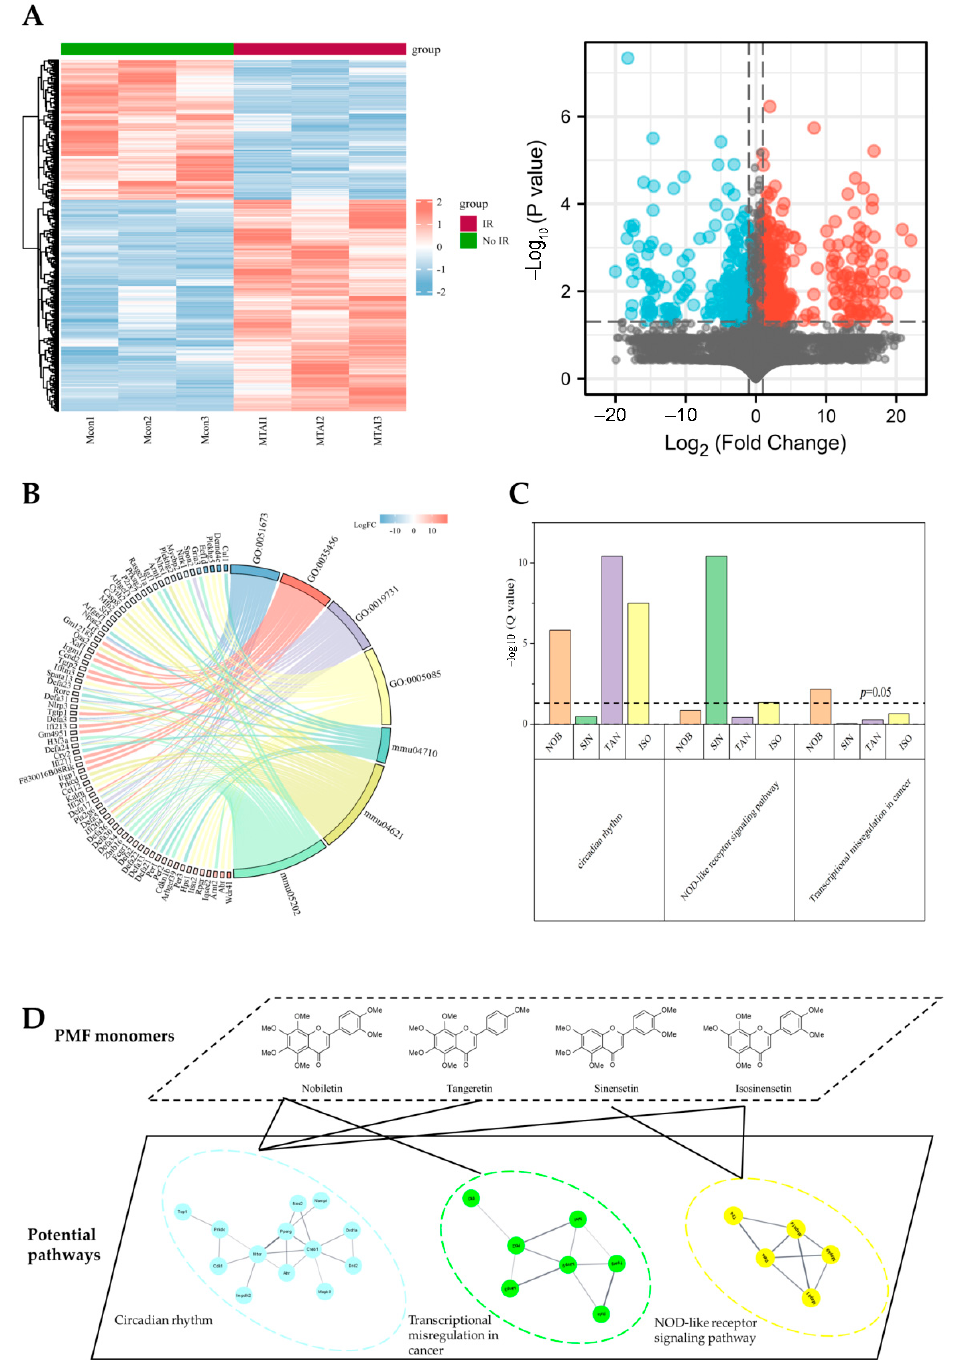
Figure 3. Bioinformatics and network pharmacology analysis of ARS and PMF targets. ( A ) Heatmap and volcano plot of differential expression genes after irradiation. ( B ) Chord diagram of GO/KEGG enrichment results and related genes. ( C ) Enrichment analysis of each monomer’s targets. ( D ) The compound–biological functional module–molecule network of PMFs.